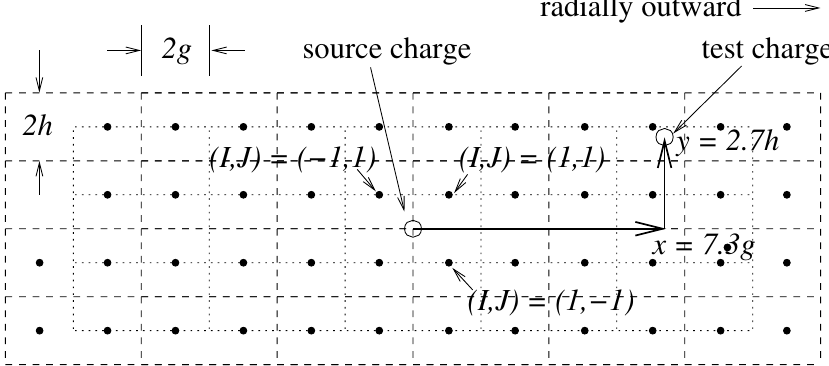
- x plotted horizontally and y t s